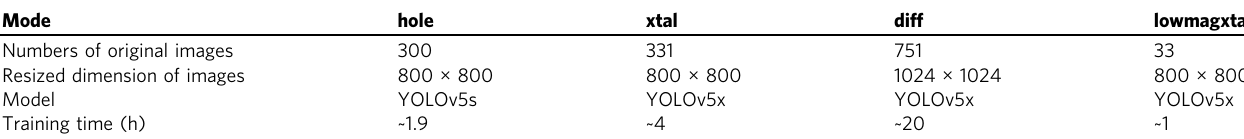
Table 1 Data statistics for training of images and diffraction patterns with